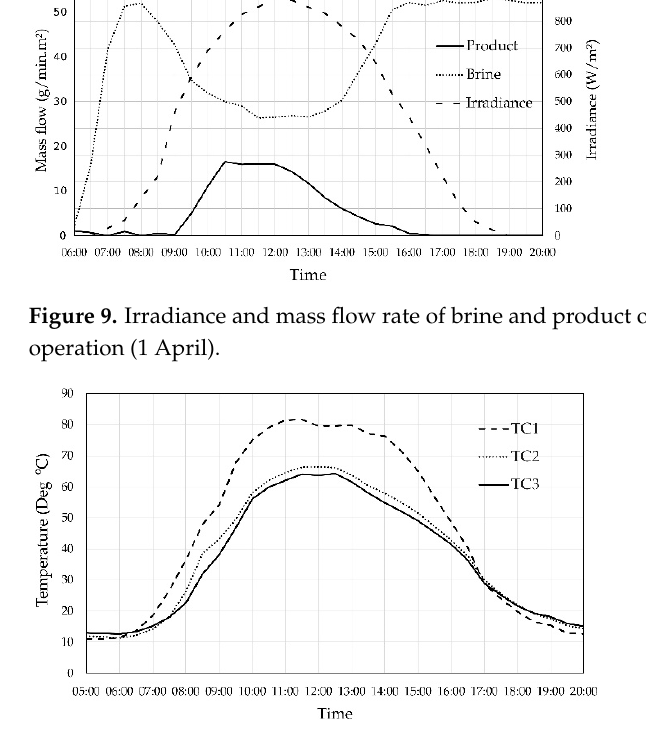
Figure 10. Temperature measured by thermocouples 1, 2 and 3 inside the MSS prototype ‐ 1 (Apr 1st).